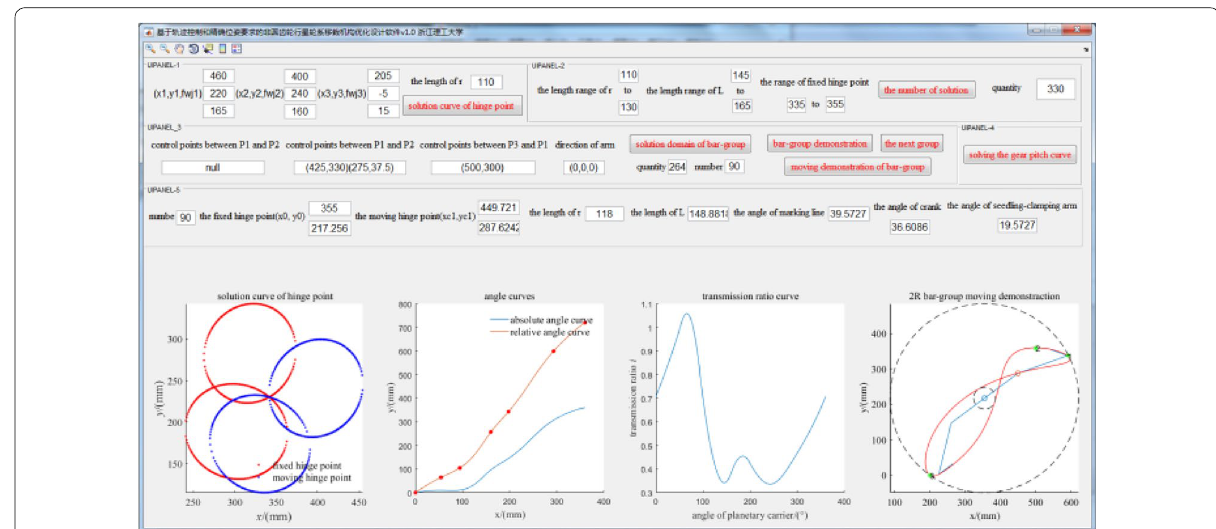
Figure 14 Mechanism-optimization design software